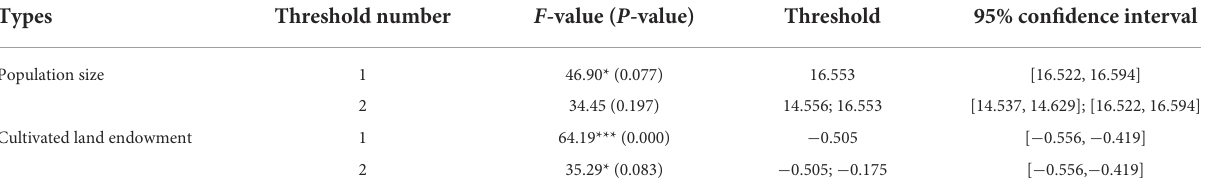
TABLE 3 Regression results of population size and arable land endowment